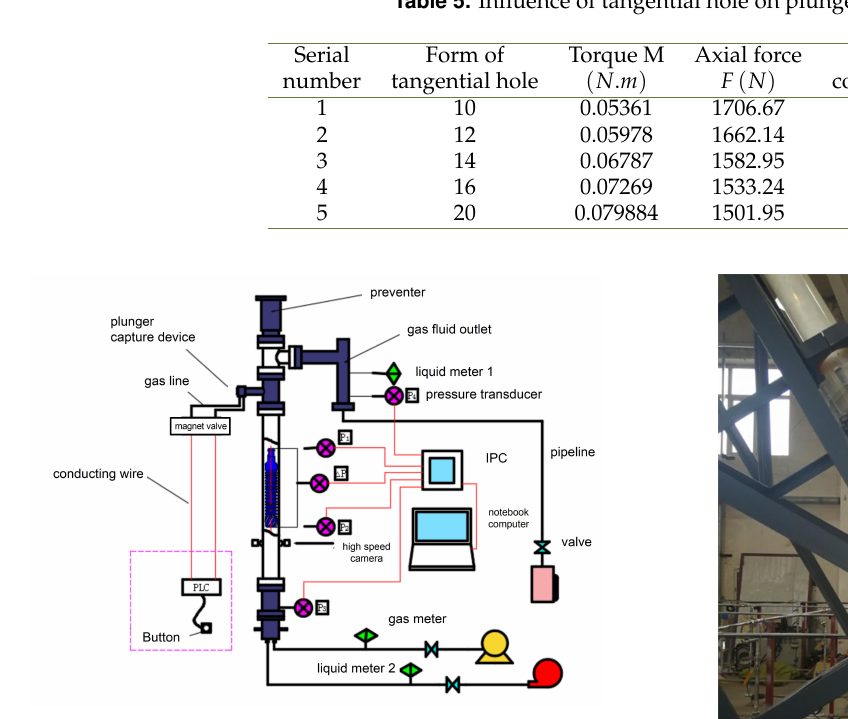
Fig. 15. Flow chart of experimental system.